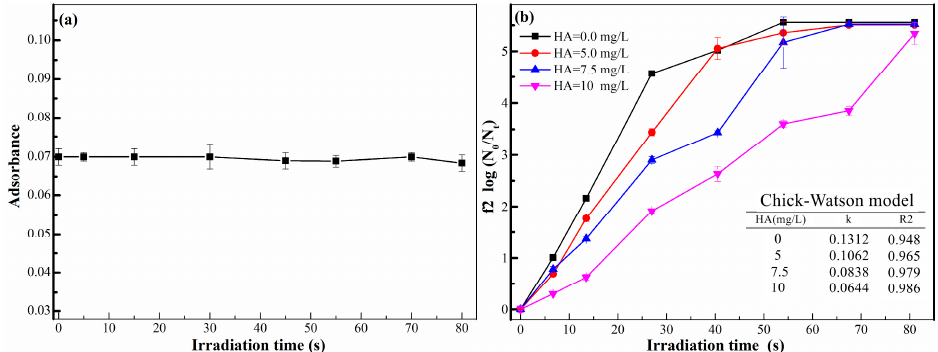
Figure 2. Degradation trend diagram of humic acid by ultraviolet (UV) ( a ) and disinfection efficiency of phage f2 with different concentration of humic acid under UV irradiation ( b ).